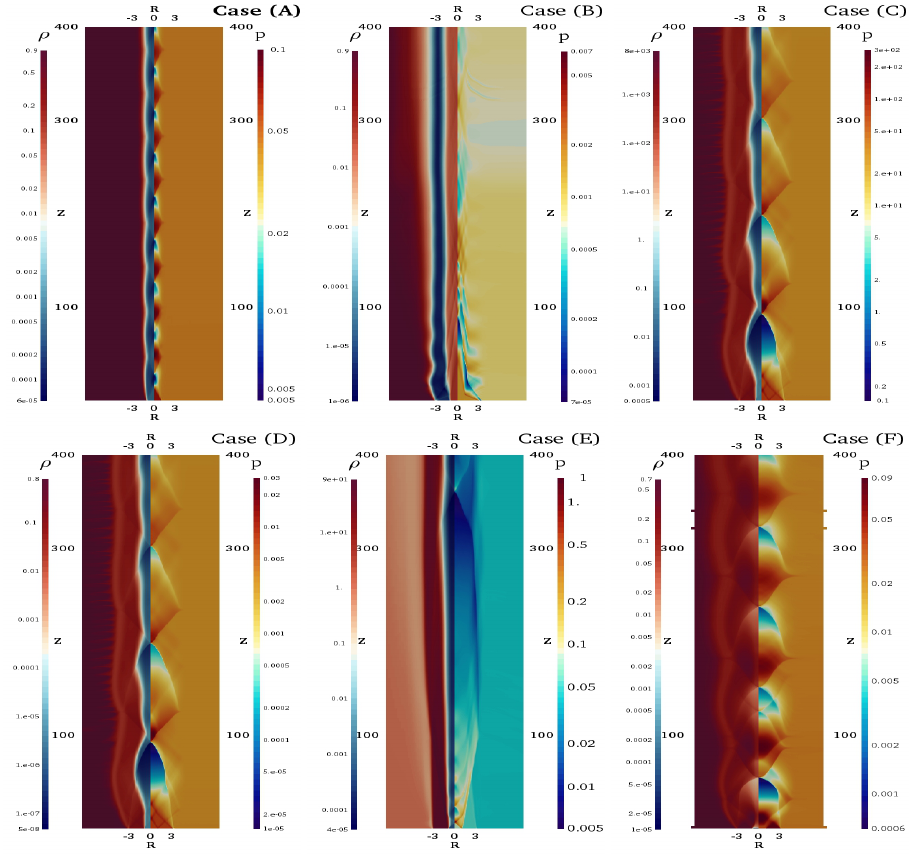
Figure 1. Two-dimensional view of all the simulated cases of the jets along the poloidal direction. In each figure, the density color bar is drawn on the left side and the pressure color bar on the right side. The jet figures are stretched in the radial direction and squeezed in the longitudinal direction.The distance R and Z and in unit of the inner jet